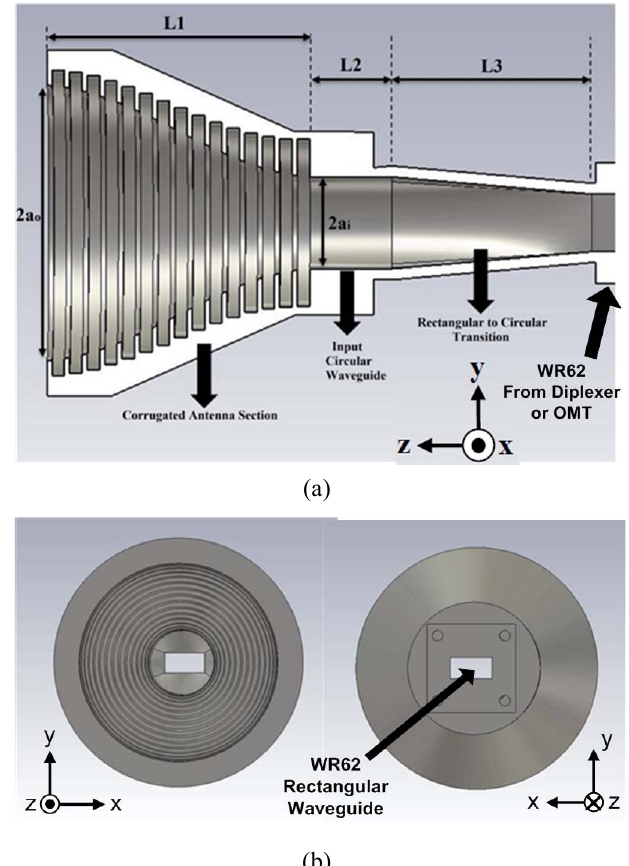
Figure 1: The views of the designed corrugated conical horn antenna (a) Cross section (side) view (b) Front and back